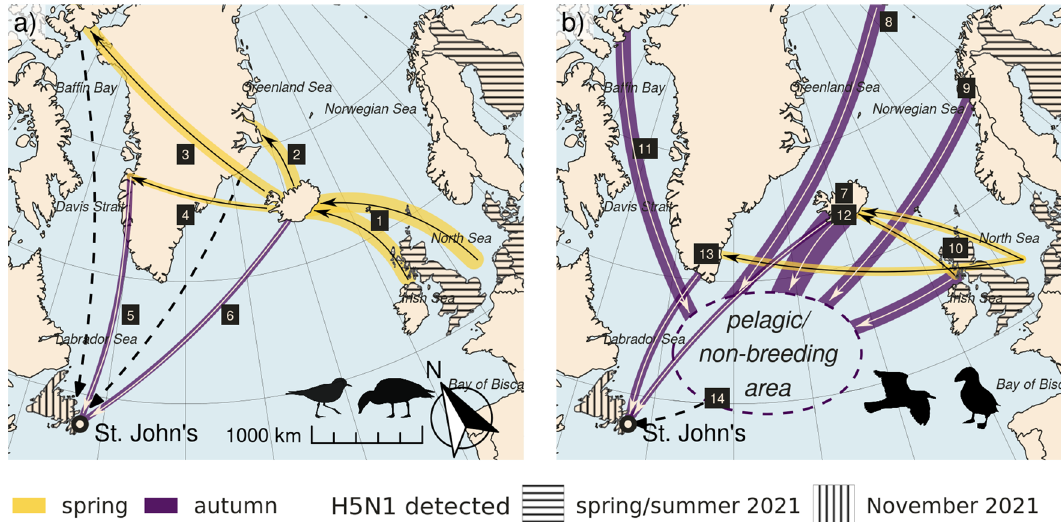
Figure 4. Maps of transatlantic migration. Putative virus transmission pathways between Europe and Newfoundland via migratory waterfowl/shorebirds ( a ) and pelagic seabirds ( b ). Many Icelandic waterfowl and shorebirds ( a ) winter in Northwest Europe and return to Iceland to breed in spring (1), including whooper swans, greylag geese, pink-footed geese, Eurasian wigeons, Eurasian teals, northern pintails, common ringed plovers and purple sandpipers. Some bird populations use Iceland as a stopover site, and continue to breeding grounds in East Greenland (2; barnacle geese and pink-footed geese), the East Canadian Arctic (3; light-bellied brent geese, red knots, ruddy turnstones) and West Greenland (4; greater white-fronted geese). Migratory birds from Europe share these breeding areas with species that winter in North America, including Canada geese and snow geese from East Greenland and the East Canadian Arctic (5), and some Iceland-breeding species of duck, including small numbers of Eurasian wigeons, Eurasian teals, and tufted ducks (6). Several seabird species ( b ), such as gulls, skuas, fulmars and auks, have large breeding ranges in the Arctic. After the breeding season many species become fully pelagic and can roam large parts of the northern Atlantic. The mid-Atlantic ridge outside Newfoundland is an important non-breeding area for seabirds, and is frequented by auks from Iceland (7), Svalbard (8) and Norway (9), including large numbers of Atlantic puffins and Brünnich guillemots, and by black-legged kittiwakes and northern fulmars originating from Iceland, Norway and the United Kingdom (7–8, 10). There these birds are joined by seabirds from Canadian and Greenlandic waters (11). Direct migratory links to Newfoundland occurs through greater and lesser-black backed gulls as well as black-headed gulls from Iceland and Greenland (12, 13), and gulls also link the pelagic and the coastal zone around Newfoundland (14). Thickness of the lines highlights the relative approximate population sizes. Dashed lines show where small numbers of individuals, or vagrants, provide a potential pathway. For more details on species and population numbers see Table 2. This figure was prepared using the software R (version 4.0.5, https:// www.r- proje ct. org/) and the following packages: -ggplot2 (version 3.3.5, https:// cran.r- proje ct. org/ web/ packa ges/ ggplo t2/ index. html), -sf (version 1.0.5, https:// cran.r- proje ct. org/ web/ packa ges/ sf/ index.